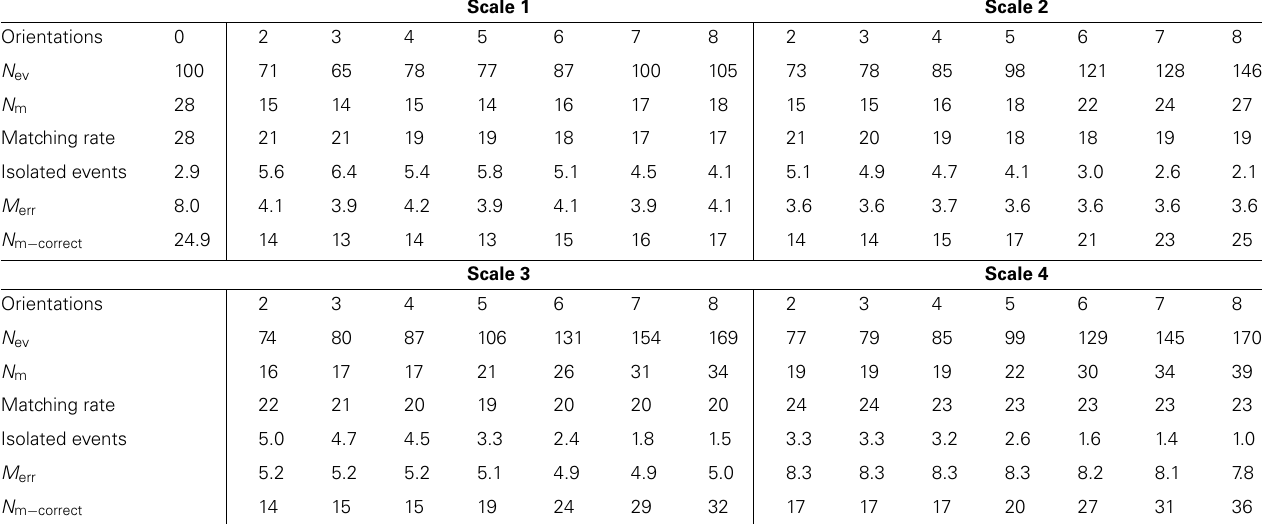
Table 1 | Comparison of the 3D reconstruction results for the pen.